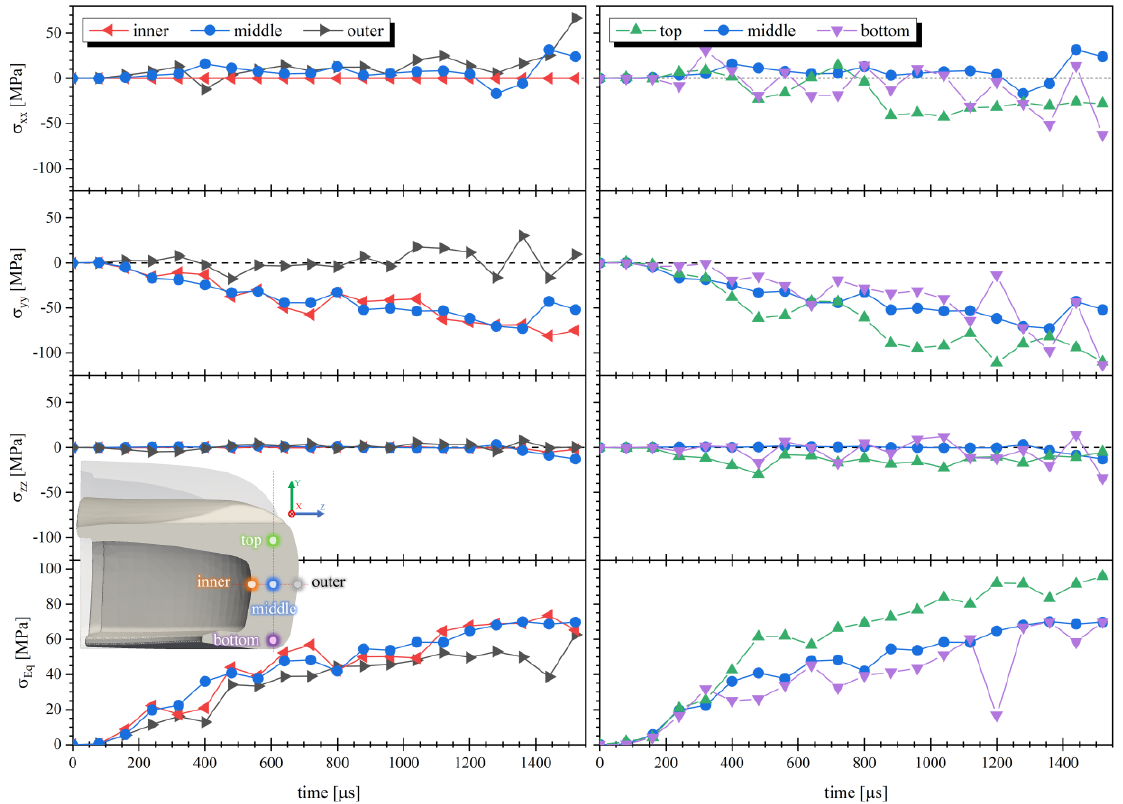
Figure 19. Stress at xx ( σ xx ), yy ( σ yy ) and zz ( σ zz ) direction, and von Mises Stress ( σ Eq ) evolution at the inner, middle and outer (left), top and bottom (right) of the toe cap horizontal and vertical y-z plane.